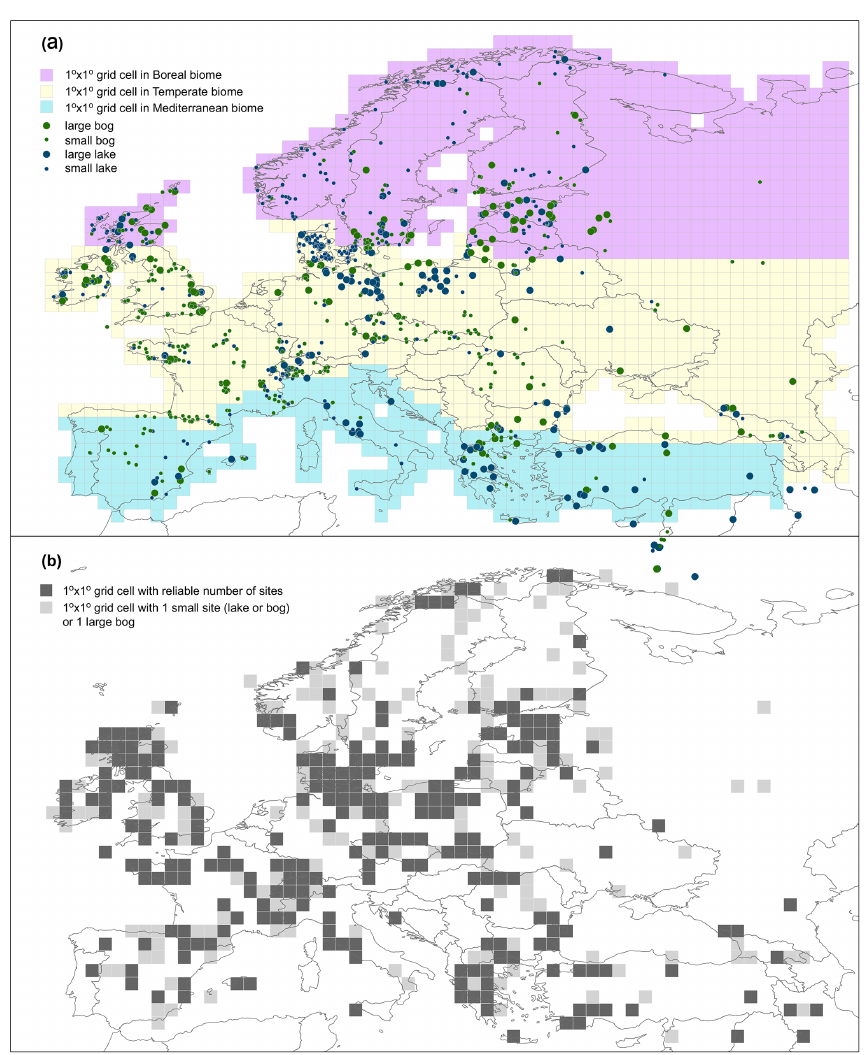
Figure 1. Study region showing site coverage. (a) Colours represent different modern biomes (purple: boreal; yellow: temperate; blue: Mediterranean), while size and colour of circle represent site type and size (see caption in panel a ). (b) Grid cell reliability dependent on number of pollen records. Black grid cells: reliable results; grey grid cells: less reliable results. Reliable: ≥ 1 large lake(s), ≥ 2 small lake(s) and/or small bog(s), mix of ≥ 1 large lake(s) and ≥ 1 small lake(s) and/or small bog(s); less reliable: 1 bog (large or small) or 1 small lake. See Sect. 4.1 for details and discussion on reliability of REVEALS